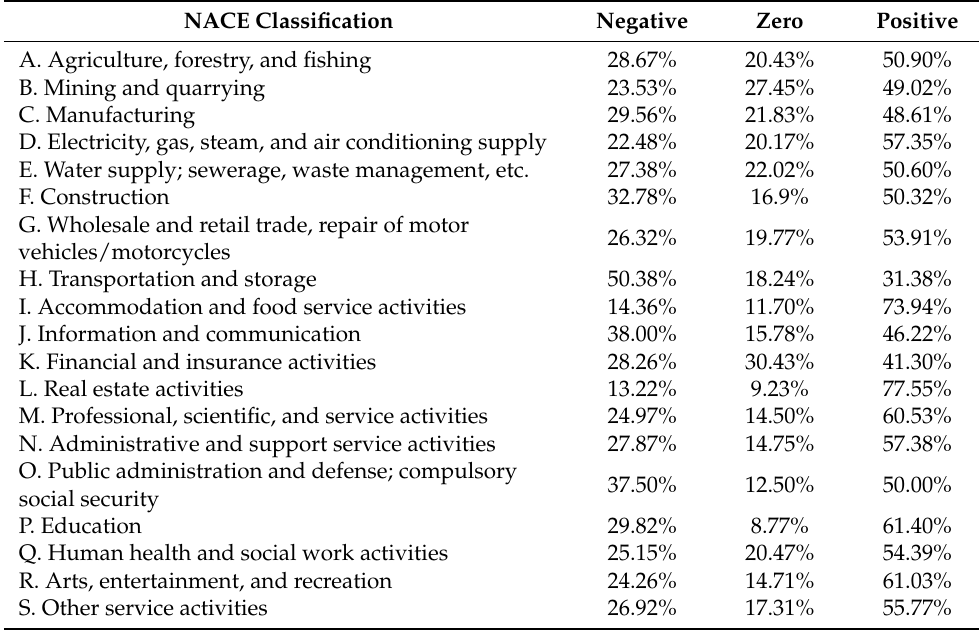
Table 5. Discretionary accrual levels across the sectors (period